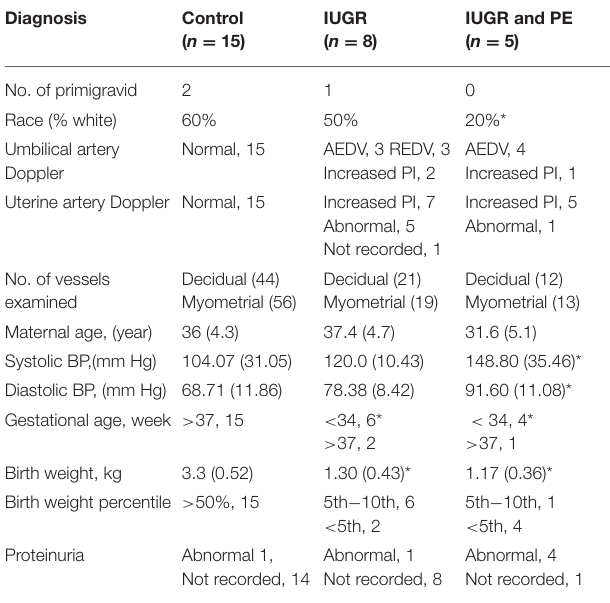
TABLE 1 | Patient demographics of the placental bed biopsy study.